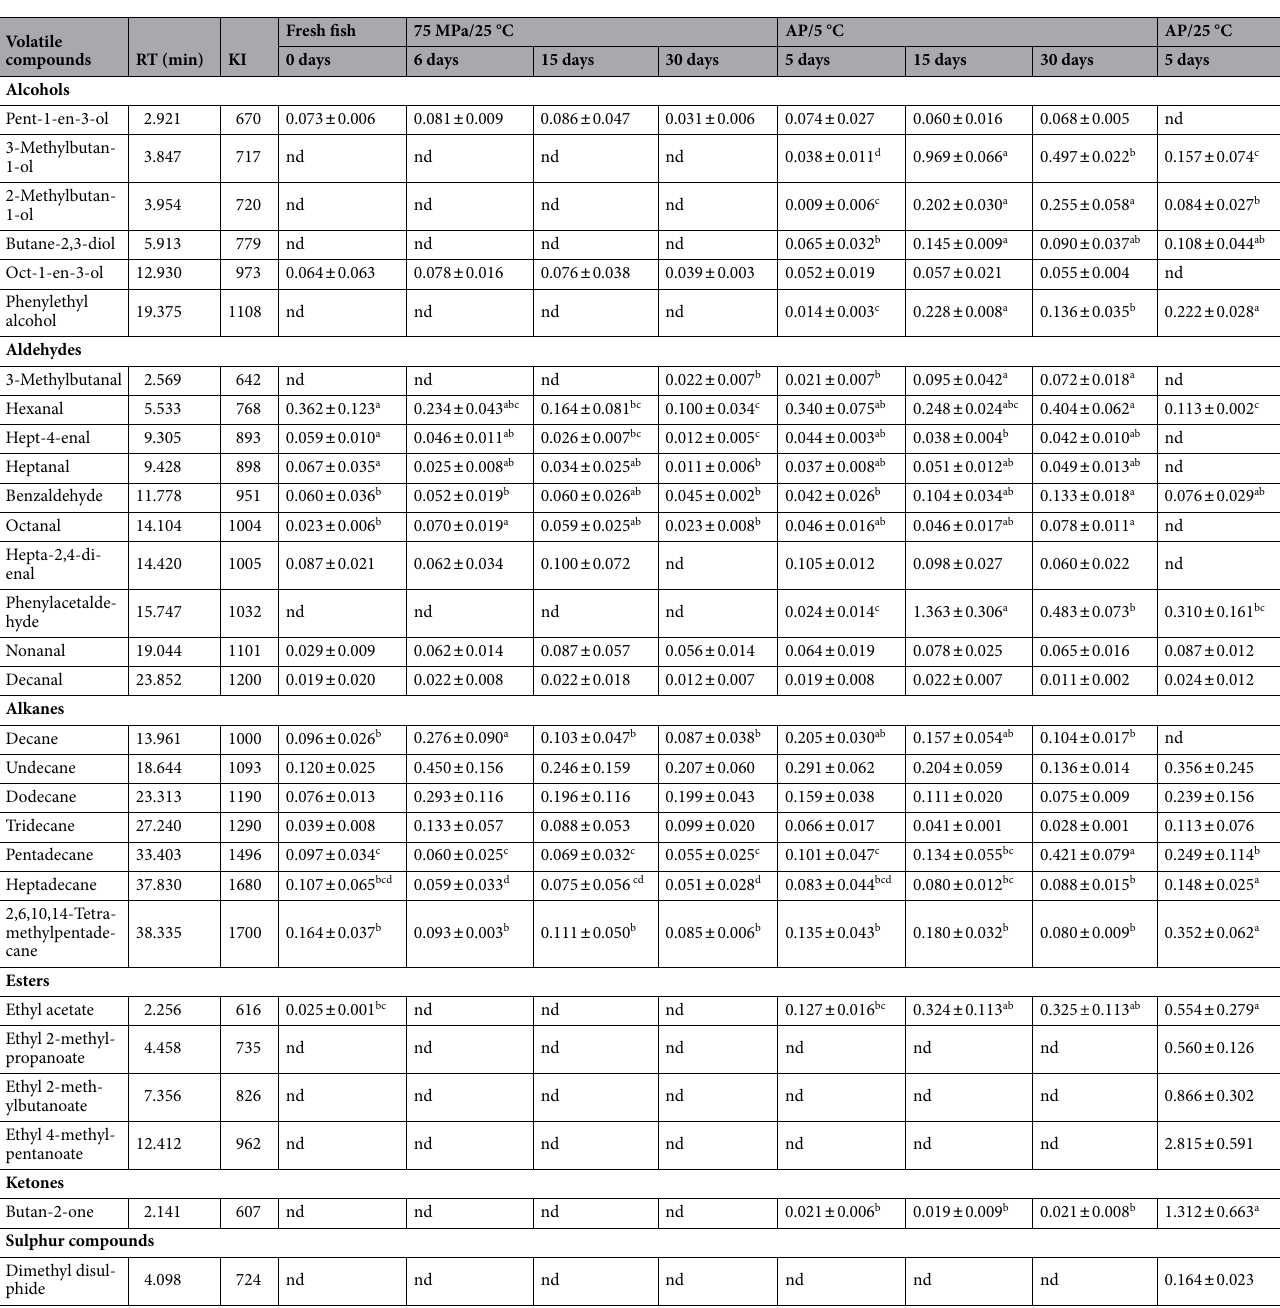
Table 2. Volatile compounds Atlantic salmon stored at 75 MPa/25 °C and AP/5 °C during 30 days, and at AP/25 °C during 5 days. Different letters along each row denote significant differences (p < 0.05); absence of letters indicates not statistically significant differences. Values correspond to the peak area of each compound/ peak area of internal standard ratio. KI experiment value of Kovats Index